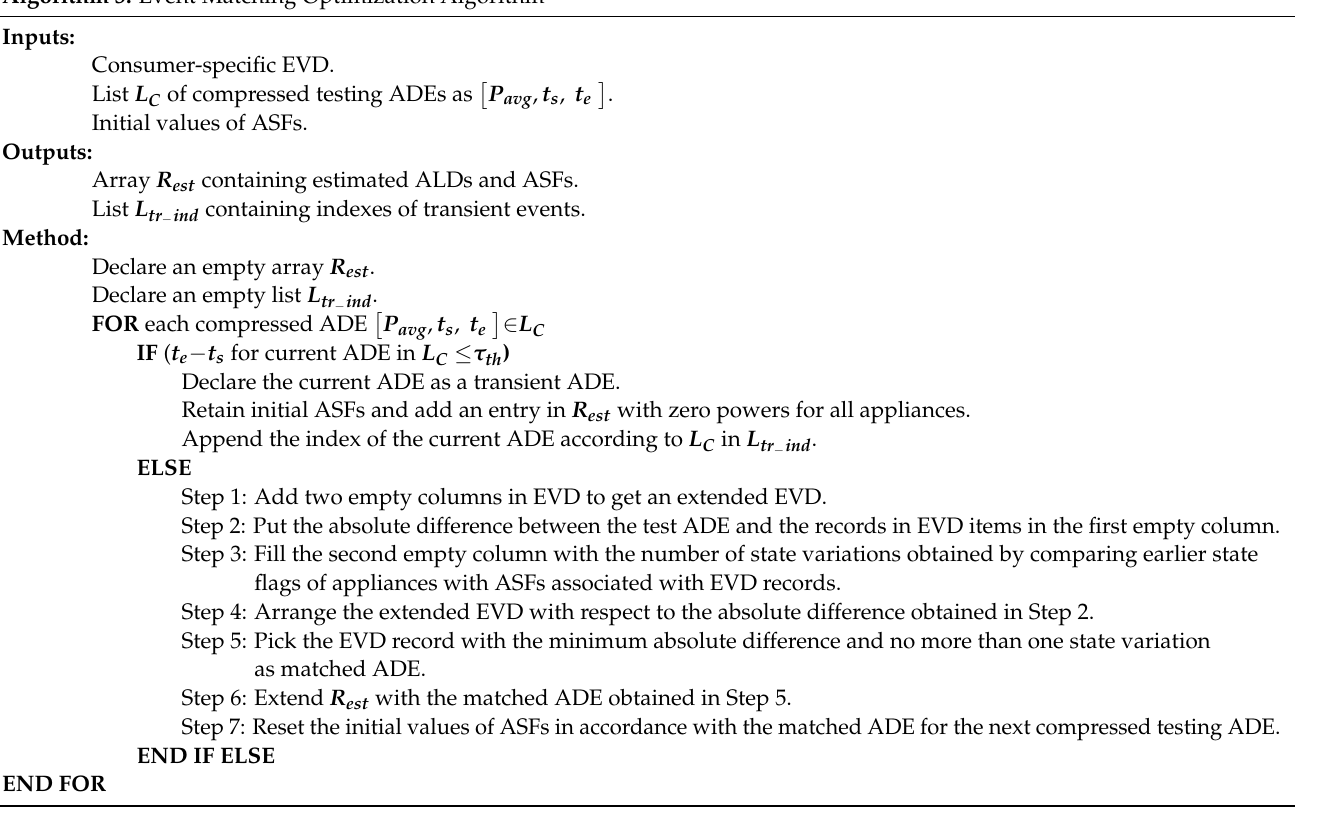
Algorithm 3: Event Matching Optimization